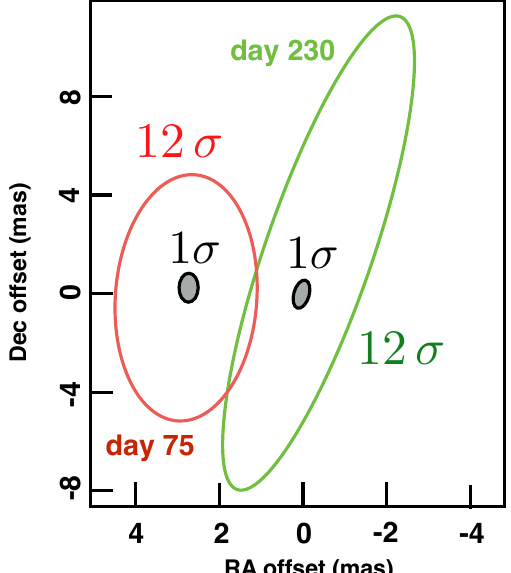
Figure 32. Proper motion of the radio counterpart of GW170817 [163] The centroid offset positions (shown by 1 σ error bars) and 12 σ contours of the radio source detected 75 d (red) and 230 d (green) post-merger with VLBI at 4.5 GHz. The radio source is consistent with being unresolved at both epochs. The proper motion vector of the radio source has a magnitude of 2.7 ± 0.3 mas. The 1 σ domains have been grey-colored not to deemphasize the effectively point-like nature of the source (a